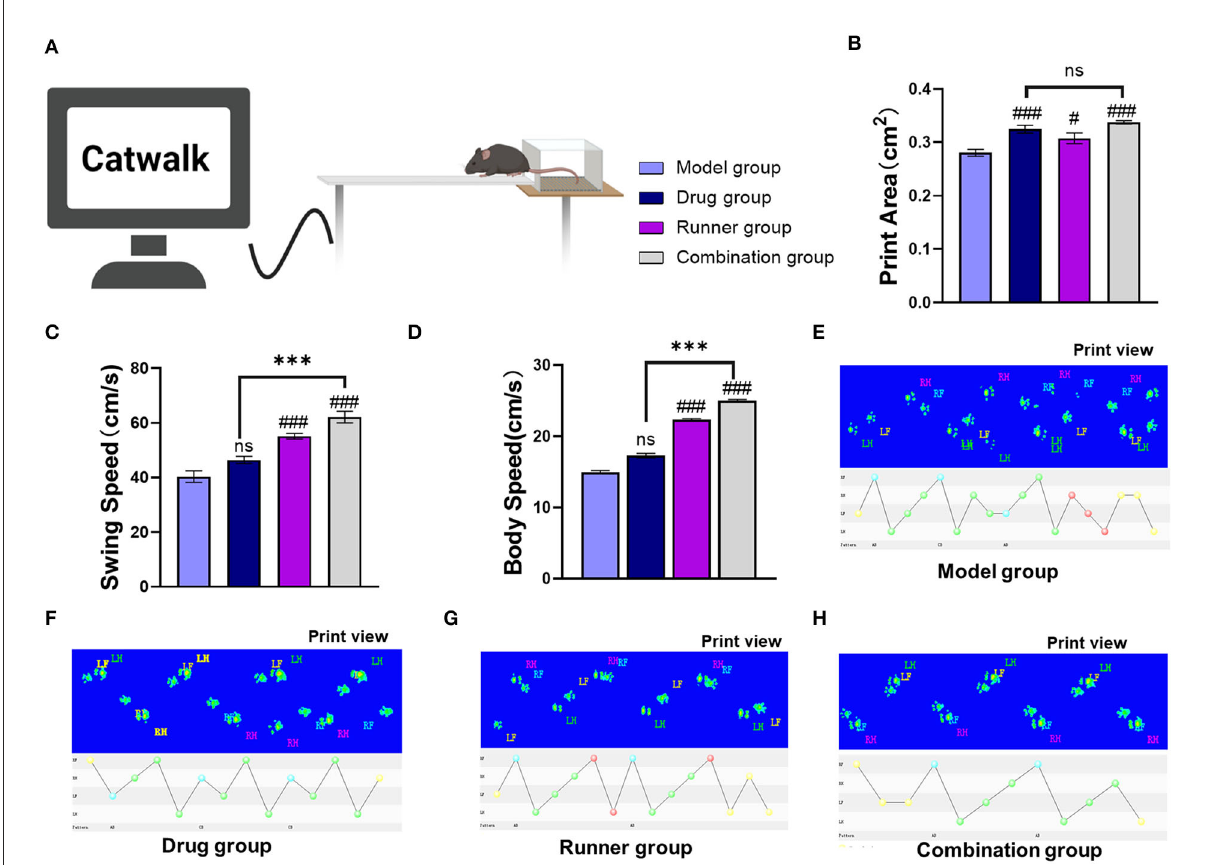
FIGURE4 Effect of LE-VPA on the gait parameters after KA. (A) Diagram of gait analysis. The Catwalk gait analysis demonstrated that auxiliary running could improve the gait posture as reflected by the increased print area (B) , swing speed (C) , and body speed (D) compared with the model group. (E–H) Displayed the footprints picture and the marching patterns of the groups. Data were expressed as mean ± SEM. ns > 0.05, *** P < 0.001; # P < 0.05, ### P < 0.001, comparison of the model group with each treated group (two-way